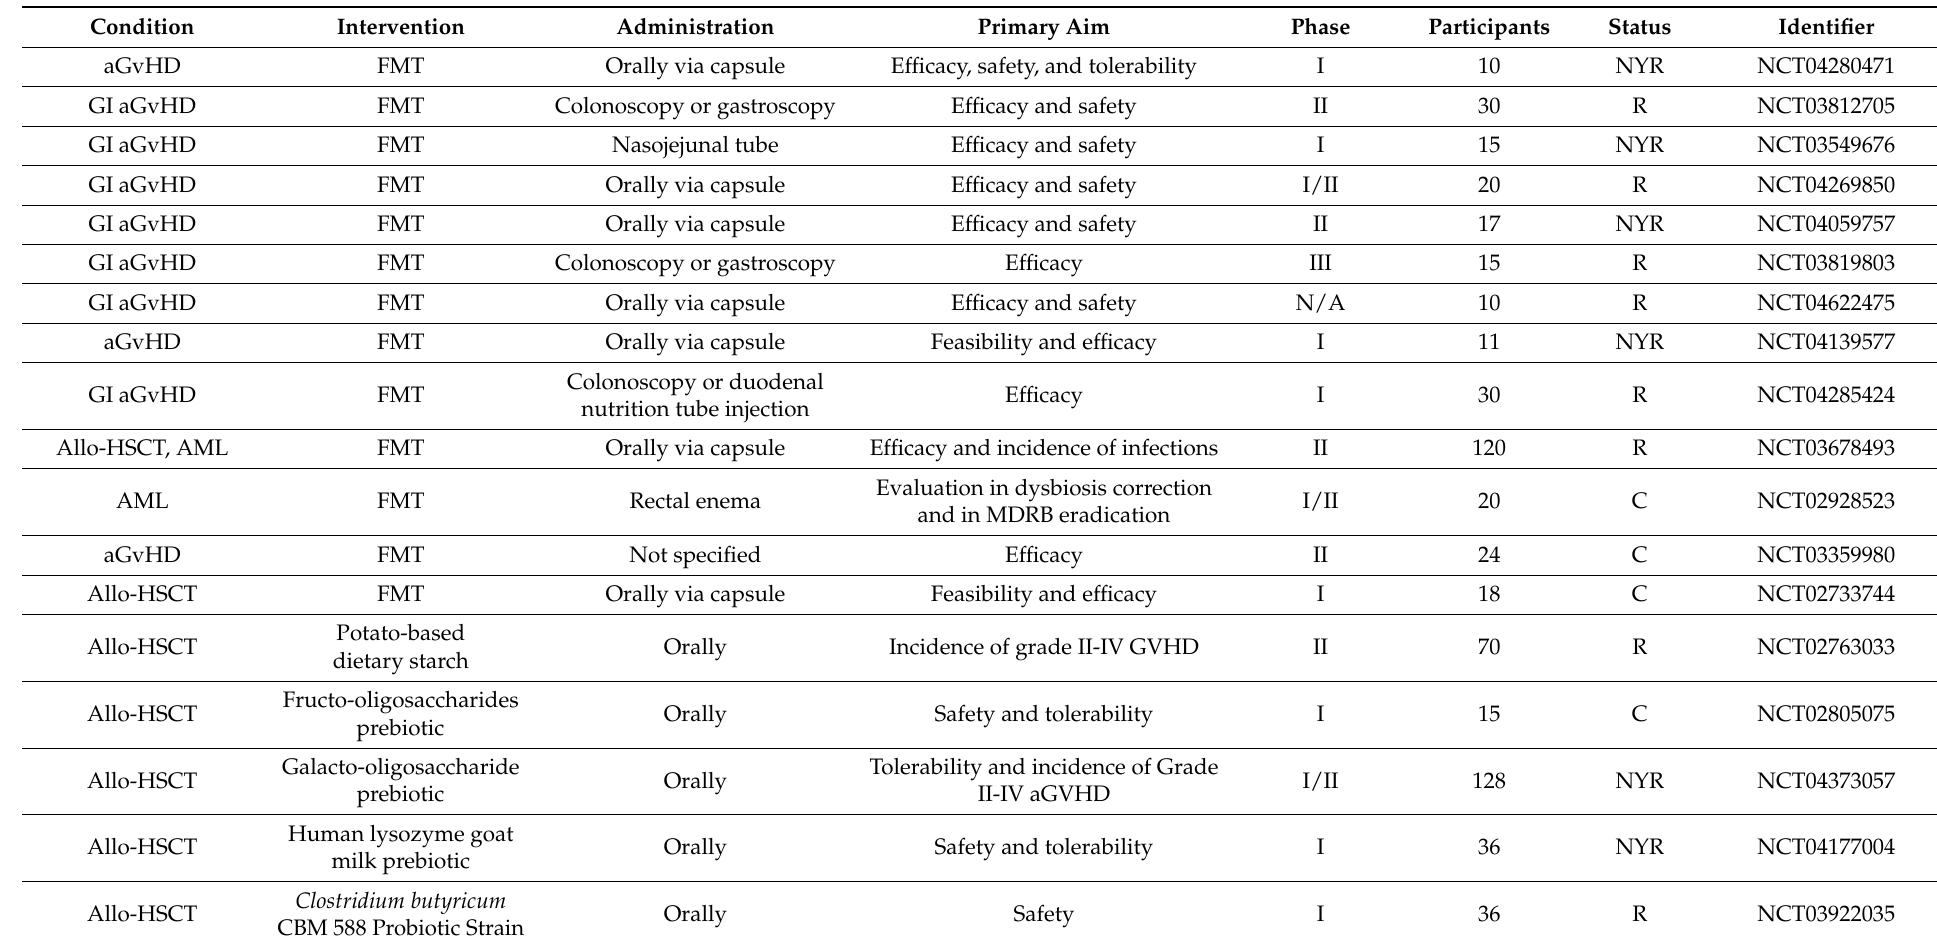
Table 3. Interventional clinical trials employing microbial products of hematological malignancies treatment and its